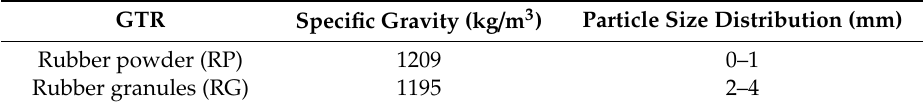
Table 2. Properties of ground tire rubber (GTR) particles.